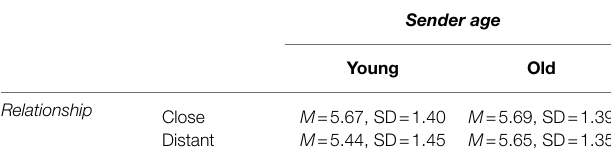
TABLE 4 | The mean score and standard deviation of friendliness by older participants.